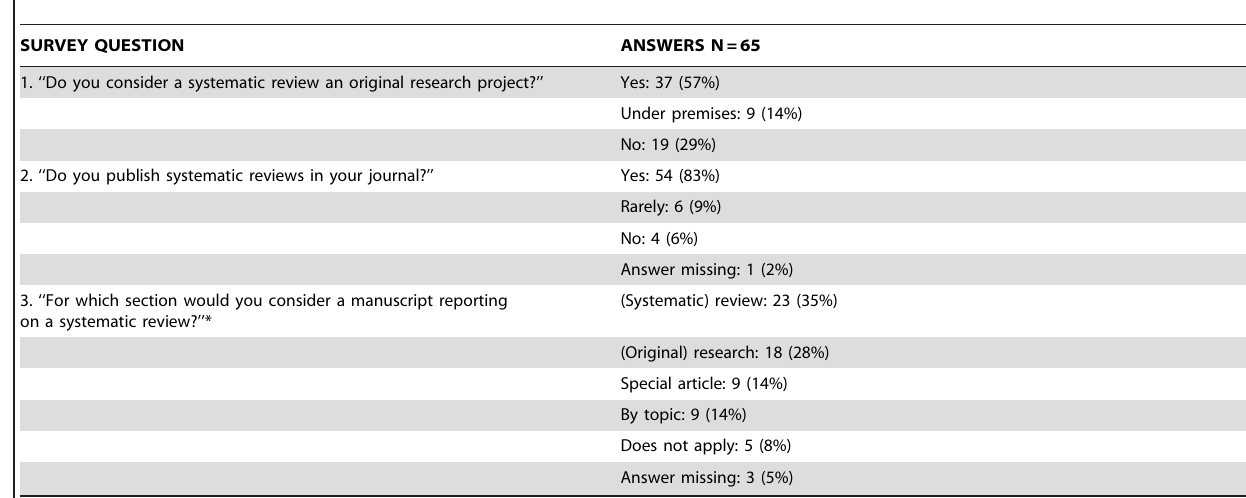
Table 2. Status of systematic reviews – results of survey of journal